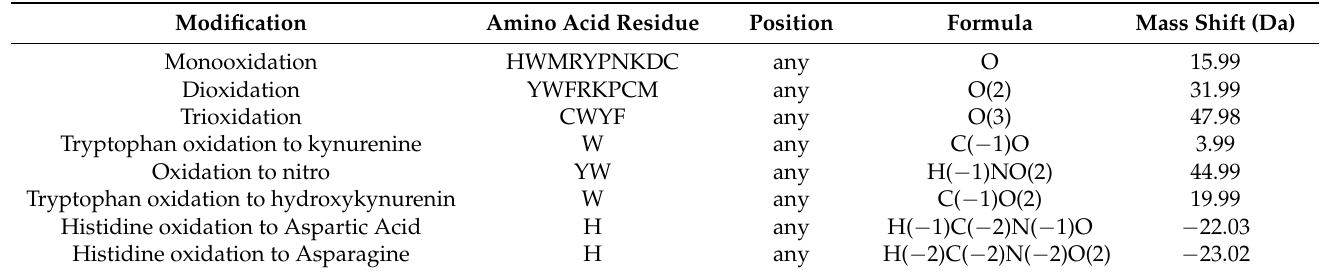
Table 1. The identified oxidative modifications of amino acid residues under the impact of two washing treatments.